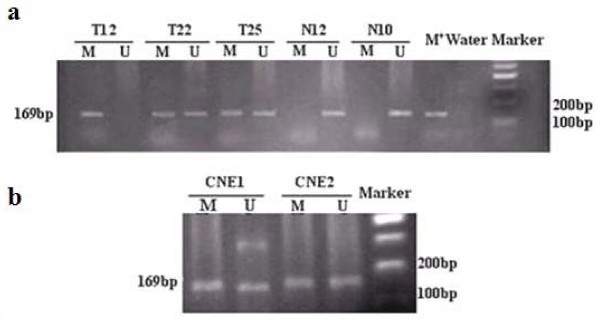
(a) Methylation-specific PCR analysis of RASSF1A promoter region in NPC primary tumors and normal nasopharyngeal tissues. Three NPCs (T12, T22, T25) and two normal nasopharyngeal (N12, N10) were showed as examples. DNA modified by methylase SssI severed as a positive methylation control and water was included as blank control. M: methylated alleles; U: unmethylated alleles. (b) Methylation status of RASSF1A in NPC cell lines CNE-1 and CNE-2, DNAs from these two cell lines could be amplified with both methylated (M) and unmethylated (U) DNA-specific primers.